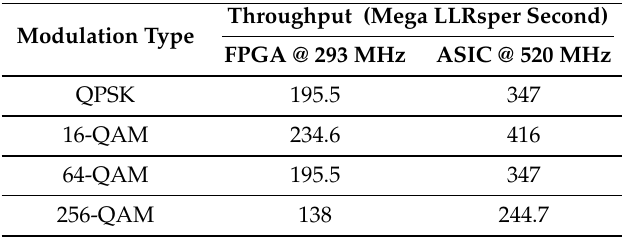
Table 4. Throughput results of the proposed NISC-based demapper architecture.